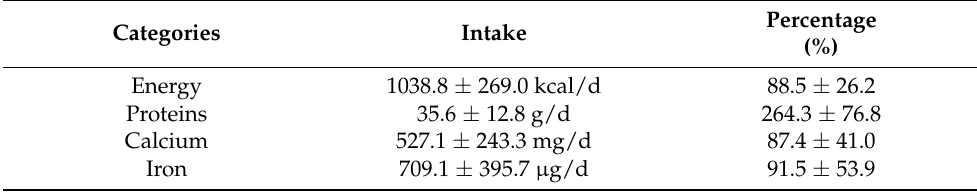
Table 7. Means of some macronutrient and micronutrient intakes and their percentages, according to French recommended nutritional intake calculated by the Nutricate© software (n =